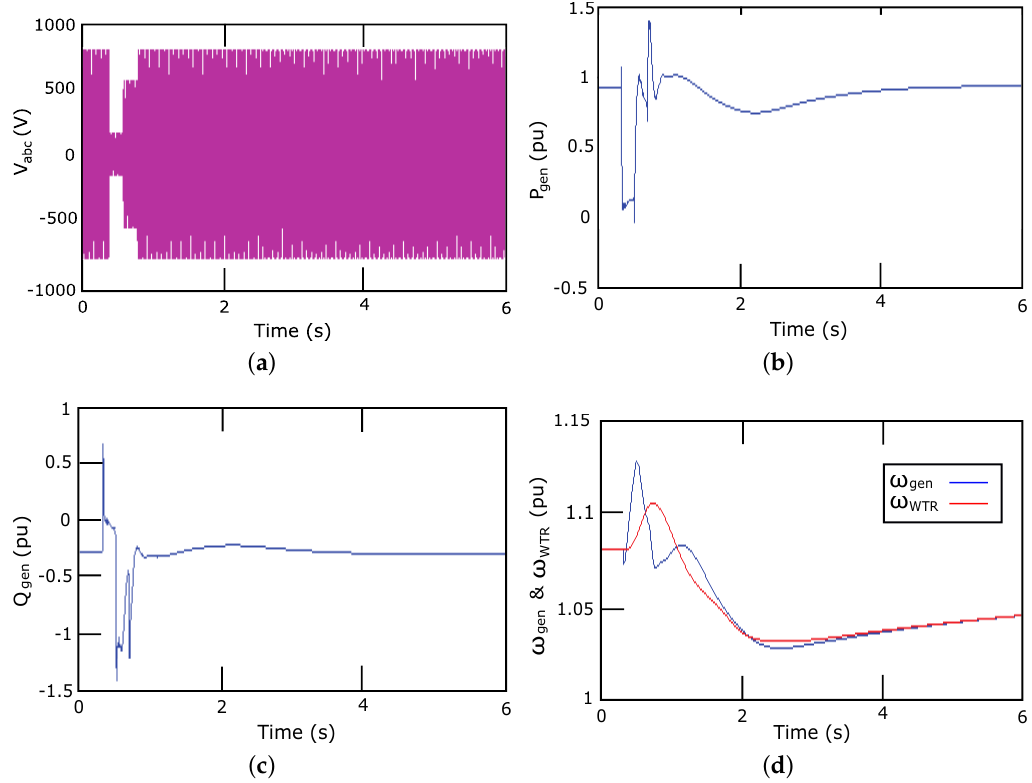
Figure 20. Response of Type 2 WT ( a ) Voltage dip ( b ) Generator active power ( c ) Generator reactive power ( d ) Generator and turbine rotational